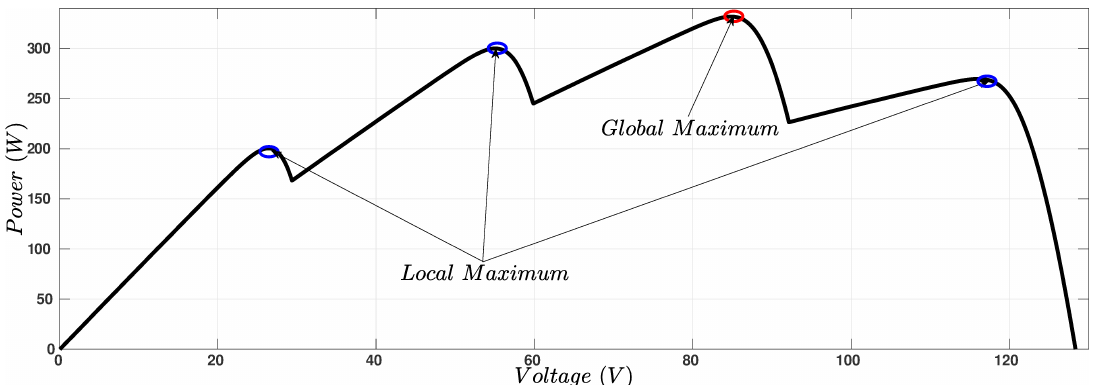
Figure 4. Characteristic multi PV panel curve with different